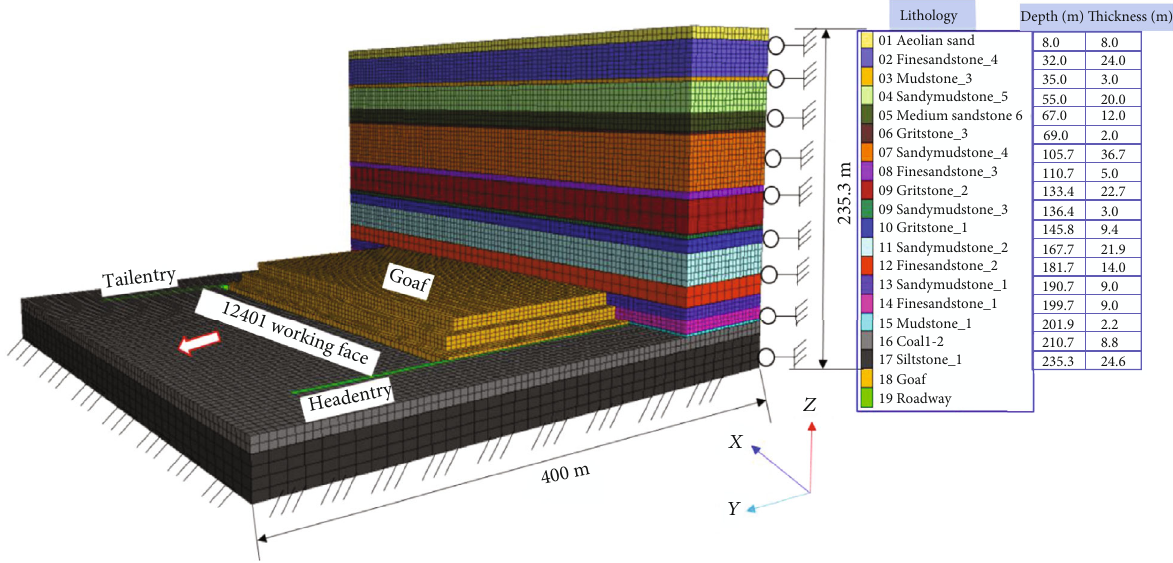
Figure 6: Numerical model of the overburden damage degree.